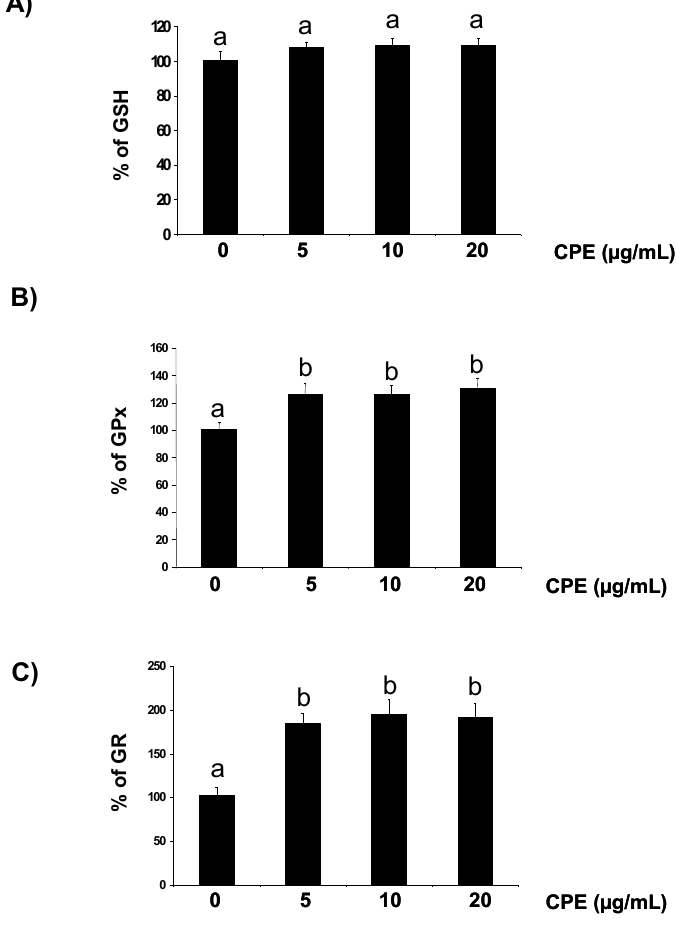
Figure 1. Effect of CPE on GSH concentration and GPx and GR activity. Ins-1E cells were treated with 5–20 μg/mL CPE for 20 h and then washed and collected to test for fluorescent analysis of GSH concentration ( A ) and spectrophotometric assay of GPx ( B ) and GR ( C ) activity. Basal values were 4.1 ± 0.9 nmol/mg protein (GSH), 52 ± 5 mU/mg protein (GPx) and 2.6 ± 0.1 mU/mg protein (GR). Values are means of 5 different samples per condition. Values are expressed as a percent relative to the control condition. Different letters indicate statistically significant differences ( p < 0.05) among different